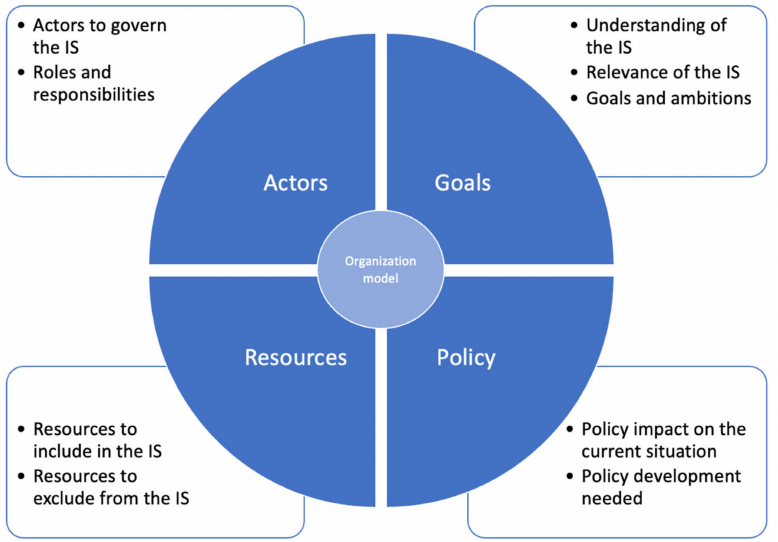
Figure 1. Framework for analyzing the impact of organization forms on actors, goals, resources, and policy in industrial